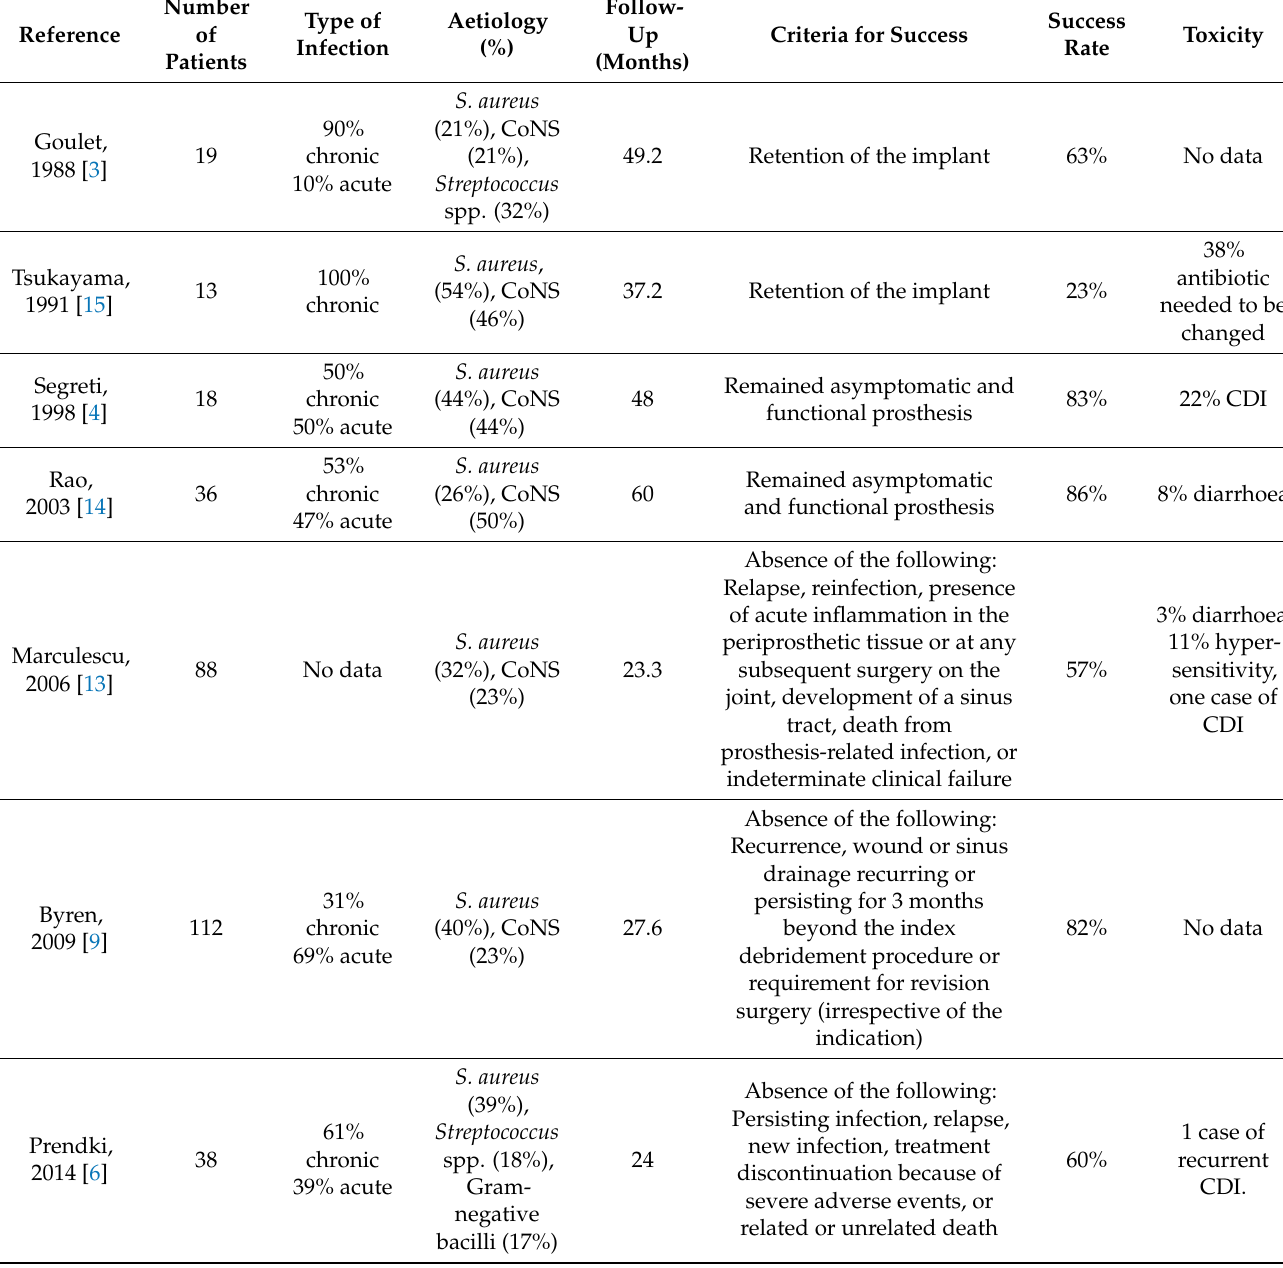
Table 1. Published Series on SAT in